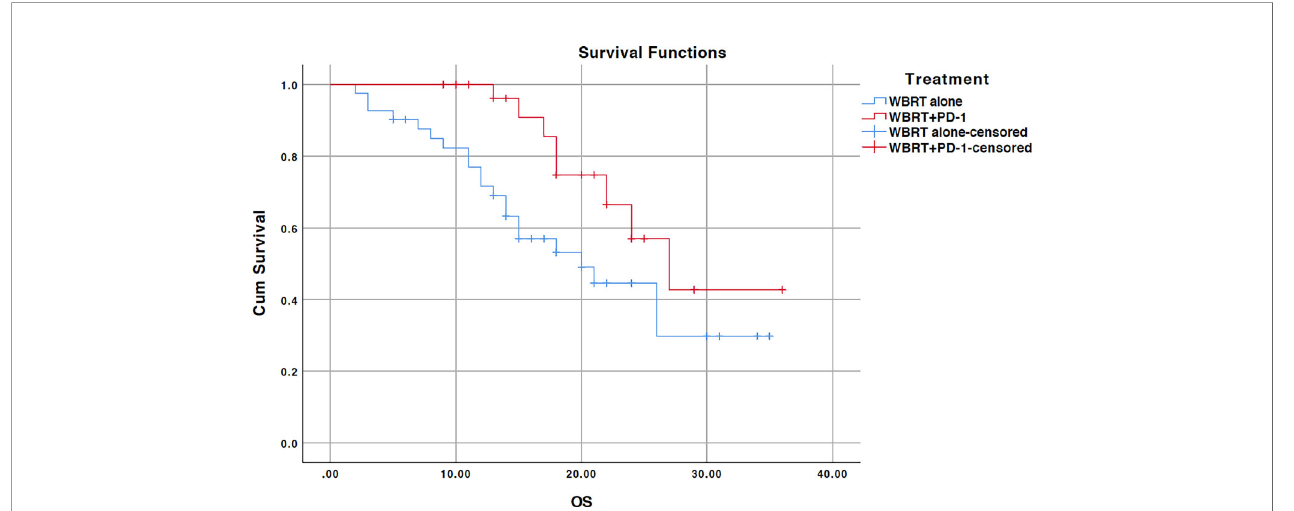
FIGURE 1 | Kaplan-Meier overall survival (OS) curve for treatments; WBRT alone (No PD-1), and WBRT plus PD-1 inhibition therapy (WBRT+PD-1). Cum,